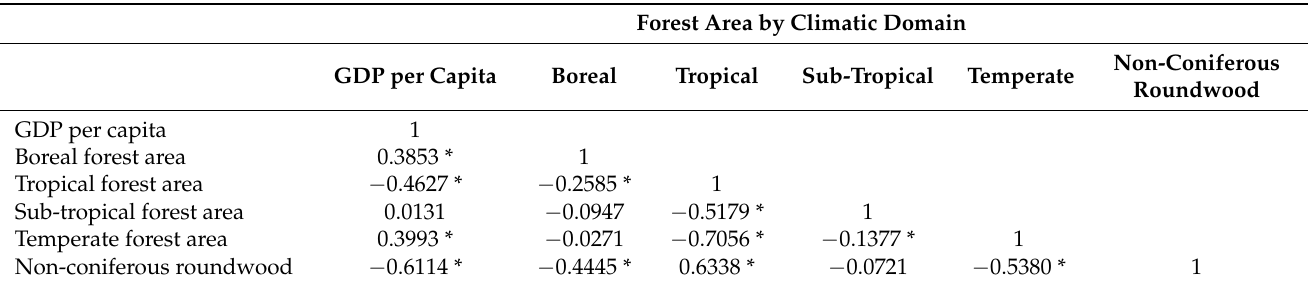
Table A1. Pairwise correlation coefficients for cluster attribute